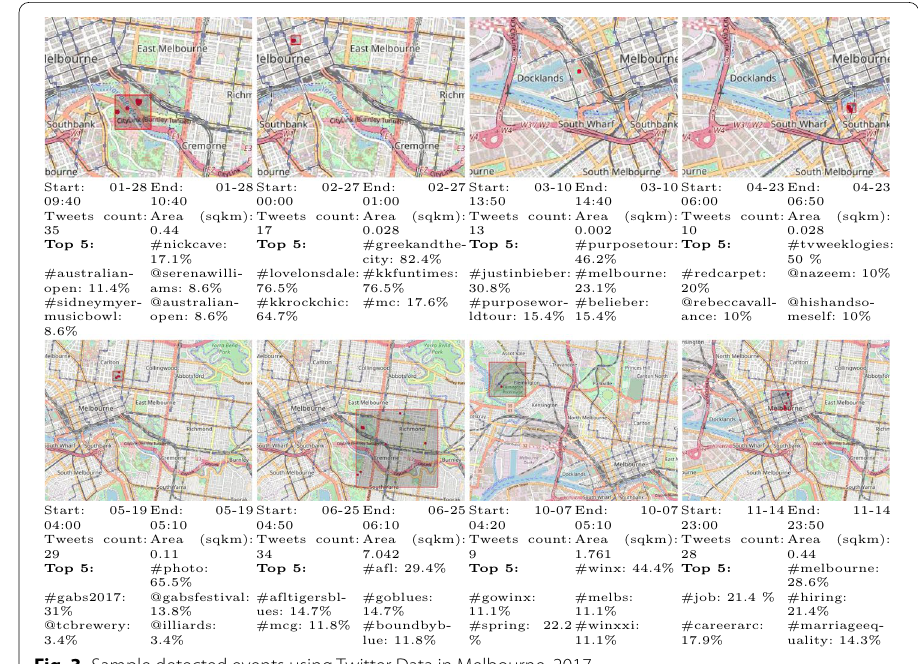
Fig. 3 Sample detected events using Twitter Data in Melbourne,